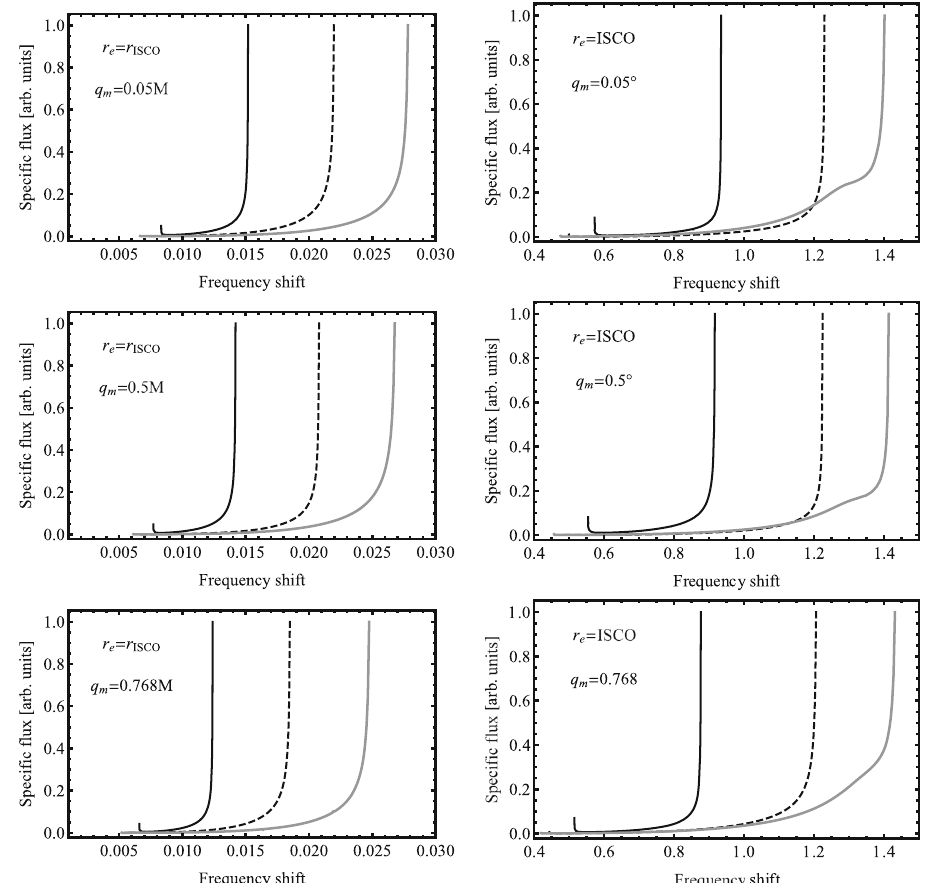
Fig. 4 Ring profiled spectral line generated. Illustration of observer inclination angle effect on spectral line properties constructed for three representative values of “magnetic charge” parameter q m = 0 . 05 M (top), 0 . 5 M , and 0 . 768 M (bottom) and three values of observer’s inclination angles θ o = 30 ◦ (black), 60 ◦ (black, dashed), and 85 ◦ (thick, gray). The ring radius is r e = r ISCO ( q m